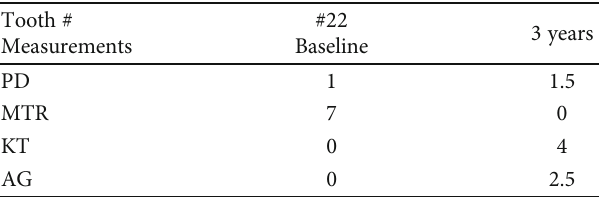
Table 2: Clinical buccal measures of the recipient area at baseline and at three years.